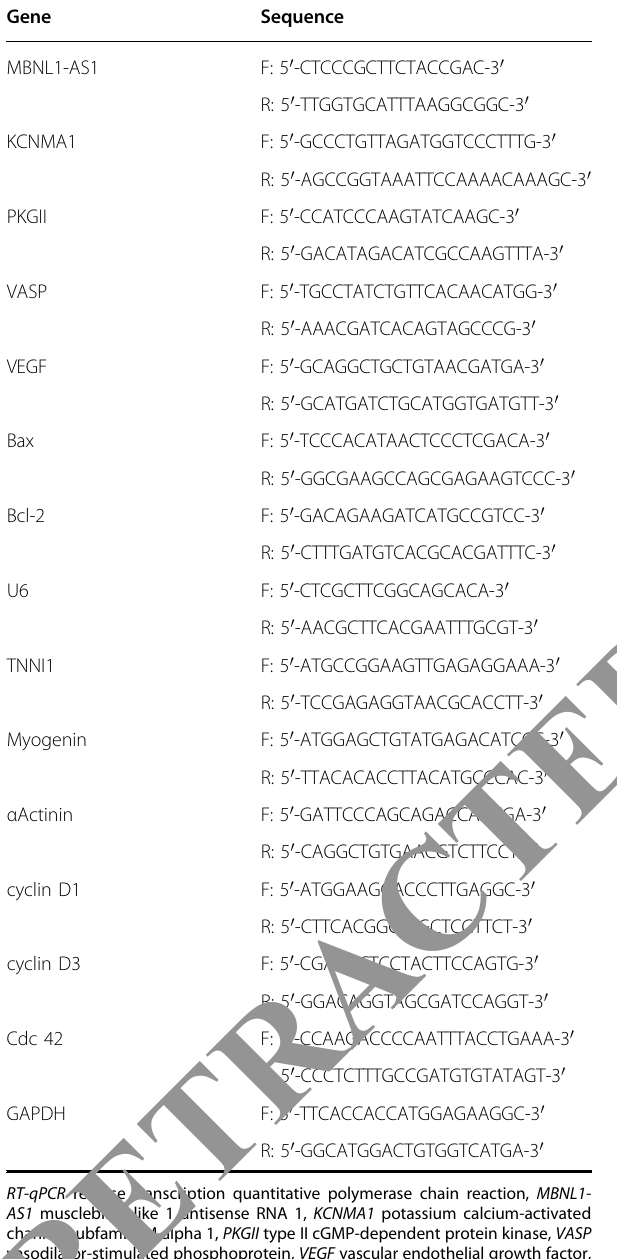
Table 1 Primer sequences for RT-qPCR Gene